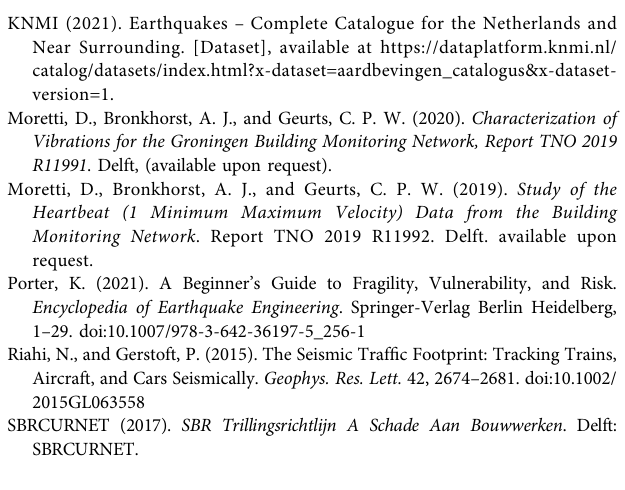
Tableman, M., and Kim, J. S. (2003). Survival Analysis Using S . First ed. Chapman and Hall/CRC. 978-1584884088.